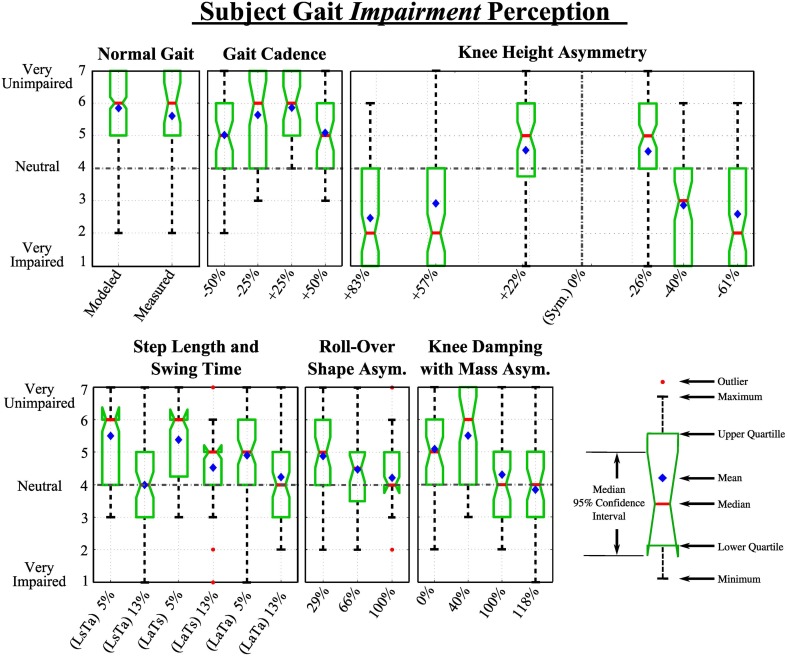
Extended box and whiskers notch plots show participant's responses to videos in each category in response to the question: “How normal and unimpaired does this gait appear?”.